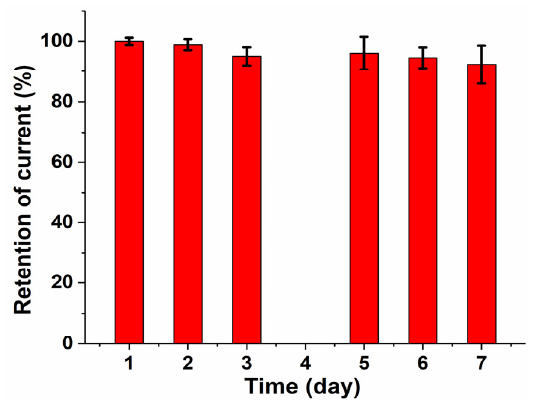
Figure 6. Response stability of 3D/RGO ‐ PEI/GOx carbon electrodes stored for 7 days at 4 °C. Table 1. Amperometric measurements of glucose in real blood serum samples (n = 3).